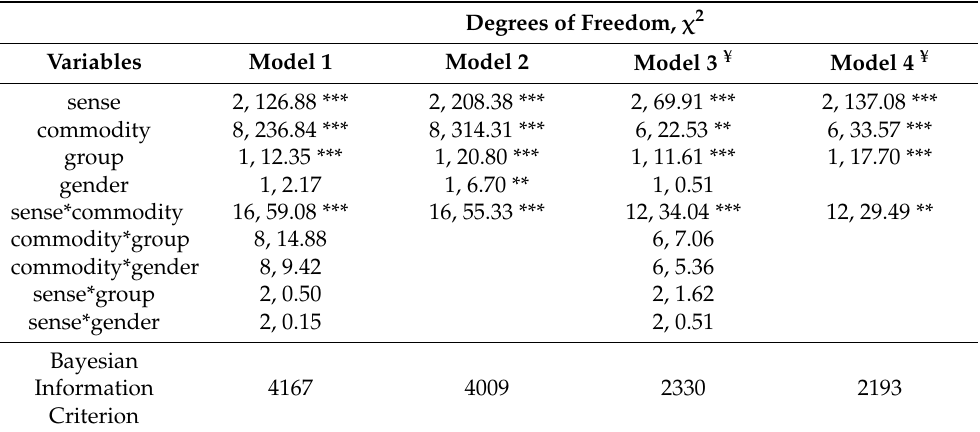
Table 2. Degrees of freedom and Chi-square statistics ( χ 2 ) with significance for generalized linear mixed models composed of key variables and their